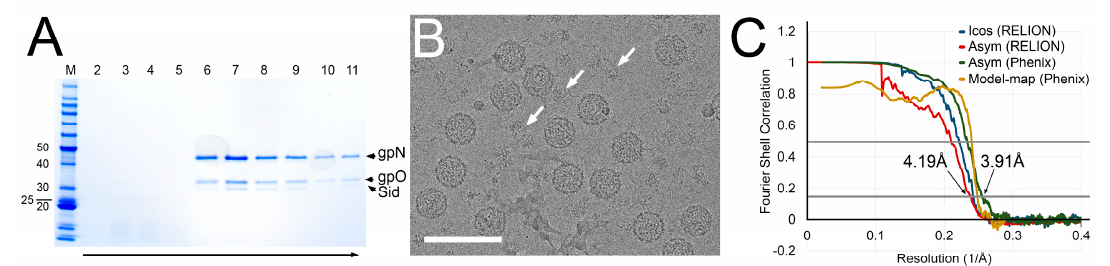
Figure 1. ( A ) SDS-PAGE from sucrose gradient purification of P4 procapsids. The lanes are labeled by fraction number, and the arrow shows the direction of sedimentation. Positions of bands corresponding to gpN, gpO and Sid are indicated. M = marker, with pertinent molecular weights (kDa) listed. ( B ) Cryo-electron micrograph of P4 procapsids. The arrows point to additional proteinaceous material assumed to be Sid. Scale bar, 100 nm. ( C ) Fourier Shell Correlation (FSC) plots for the icosahedral (blue) and asymmetric (red) reconstructions calculated in RELION, for the asymmetric map calculated in Phenix (green) and the correspondence between the atomic model and the reconstruction (yellow), calculated in Phenix. The gray lines show the 0.143 and 0.5 cuto ff